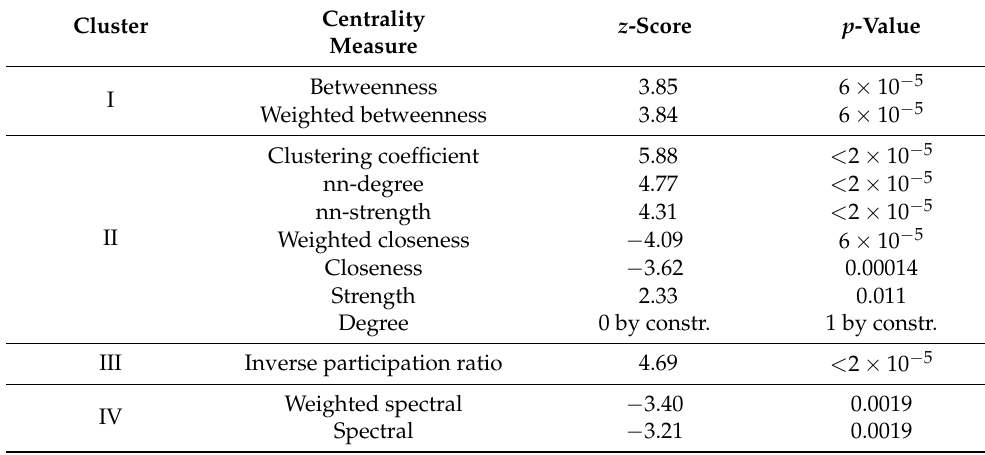
Figure 4. Box-Cox normalized distributions for the TD group (blue) and single values for the AUT group (red) for the node centrality measures. Table 2. The z -scores and p -values for the node centrality measures, grouped according to the clusters found in Section 3.3 and ranked within each cluster based on the z